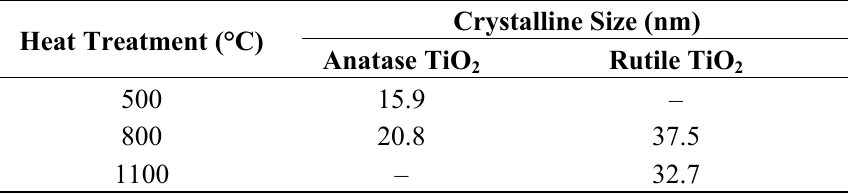
Table 1. Average values of the crystalline grain size of anatase and rutile phase TiO annealed at different